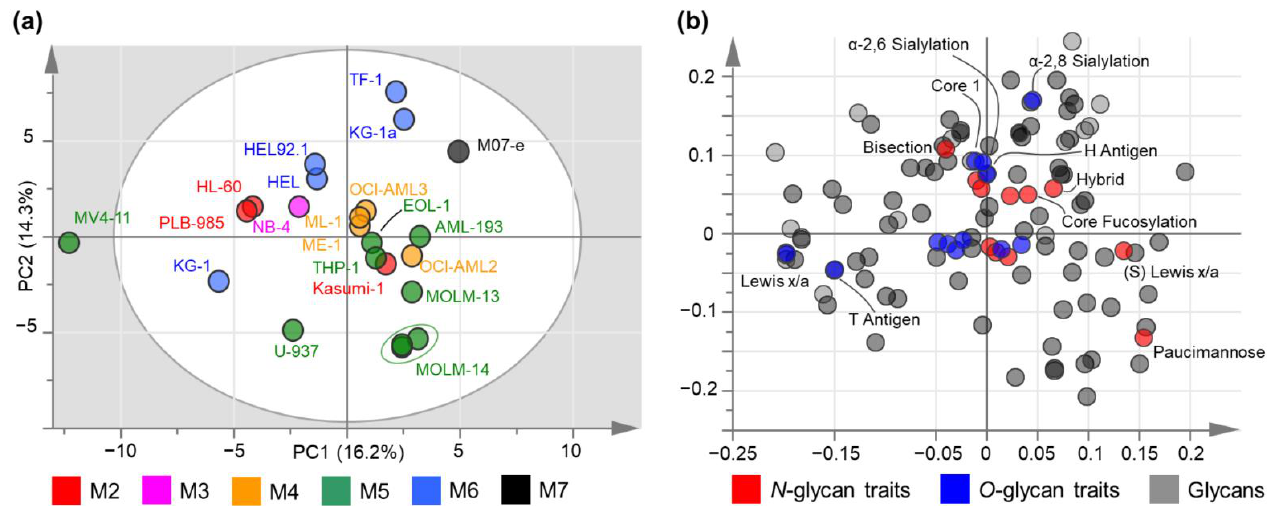
Figure 3. Unsupervised principal component analysis (PCA) of quantitative N - and O -glycomics data obtained from 21 AML cell lines. ( a ) Score plot of AML cell lines colored according to their FAB classification, as listed in Supplementary Table S1 [45,46]. Exemplarily, the MOLM-14 cell line was plotted as three independent biological replicates (green circle). ( b ) Corresponding loading plot depicting contributions of glycans and traits to the first and second principal component of the PCA. Individual glycans are colored in grey, whereas glycan types and derived traits are shown in red for N -glycans and in blue for O -glycans.